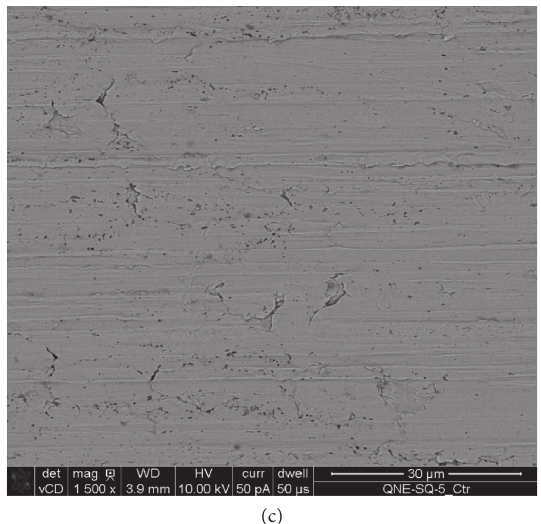
Figure 5: Reference samples (scale shown in the figures). (a) Reference sample 1 (ambient conditions) at low magnification. (b) Reference sample 1 (ambient) at high magnification. (c) Reference sample 2 (SpaceQ brine) at high magnification.